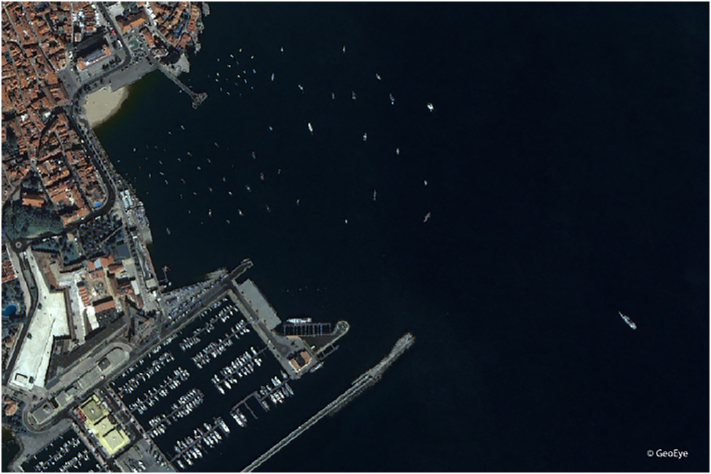
Detail of a GeoEye-1 optical image of Cascais (Portugal), acquired in October 2011, with a spatial resolution of 1.65 m (RGB composite). This image shows that vessels can be visually easily recognised from the image when there are no clouds or waves present, which implies that they can also be recognised by automatic processing methods.